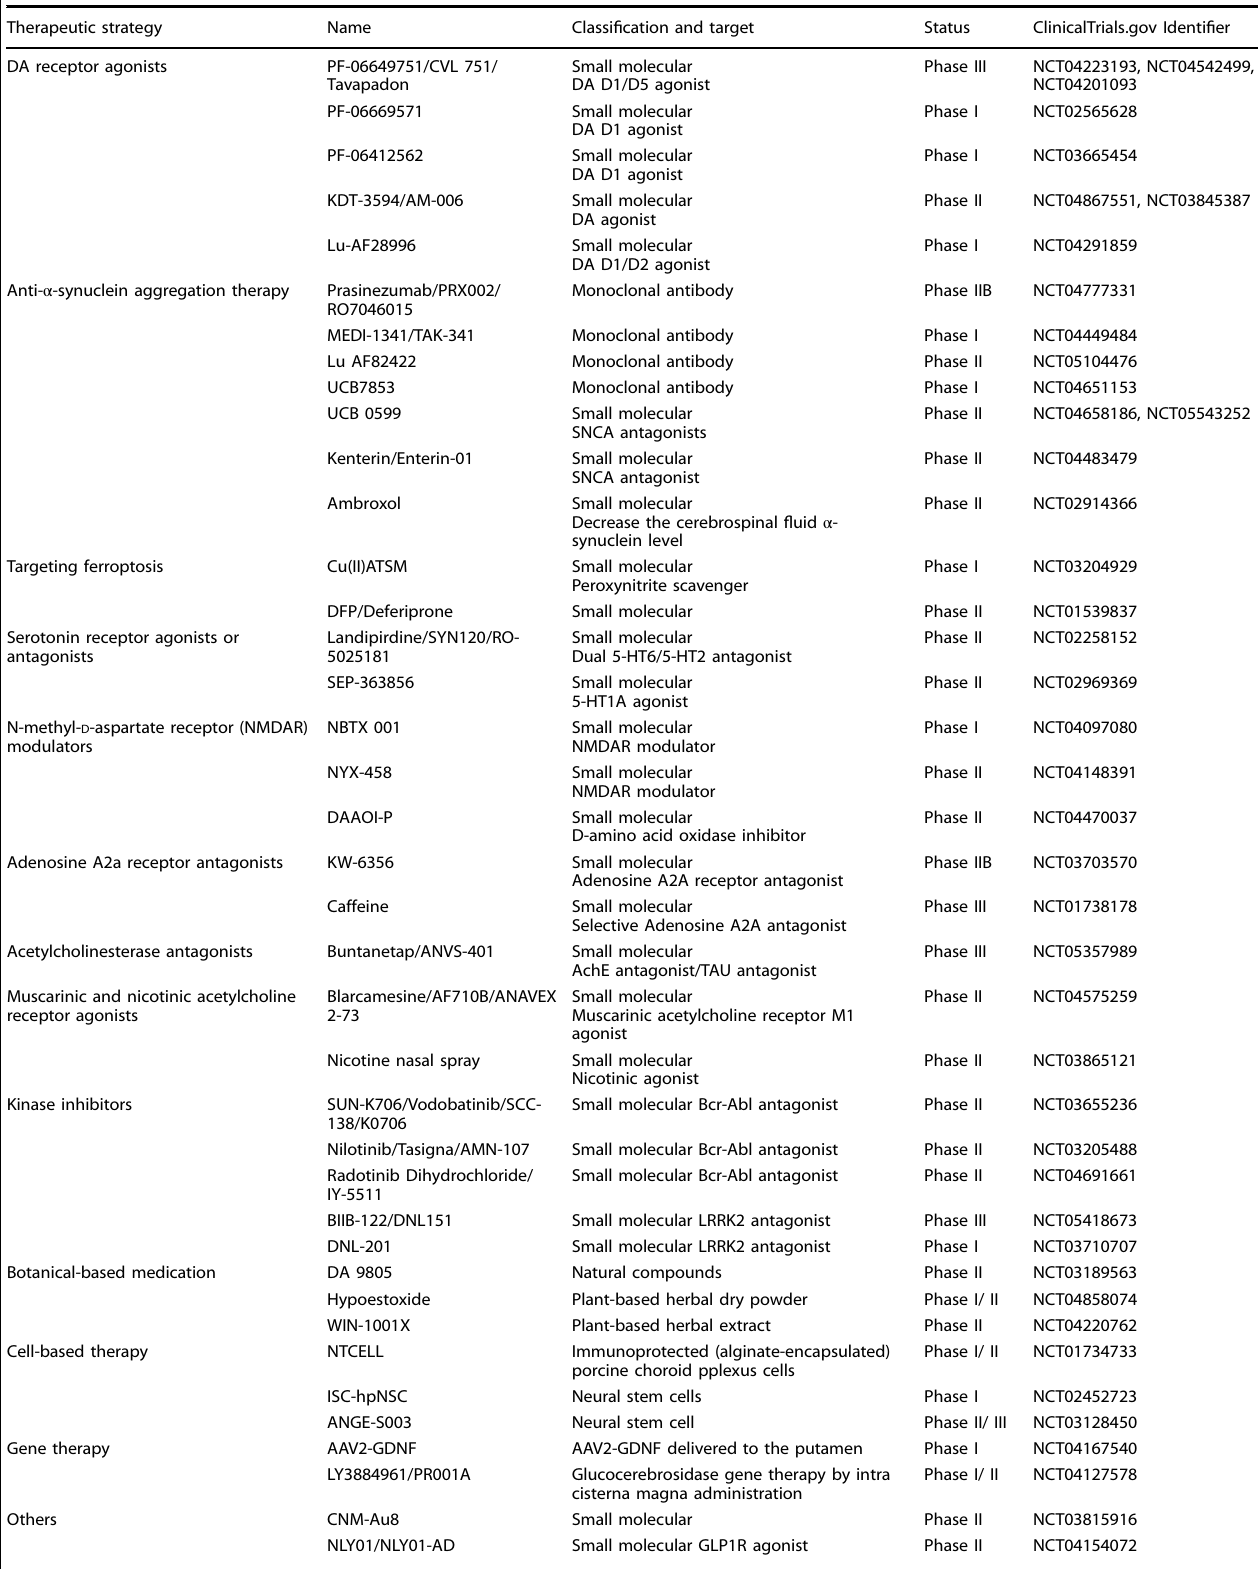
Table 2. Clinical therapeutic interventions for PD